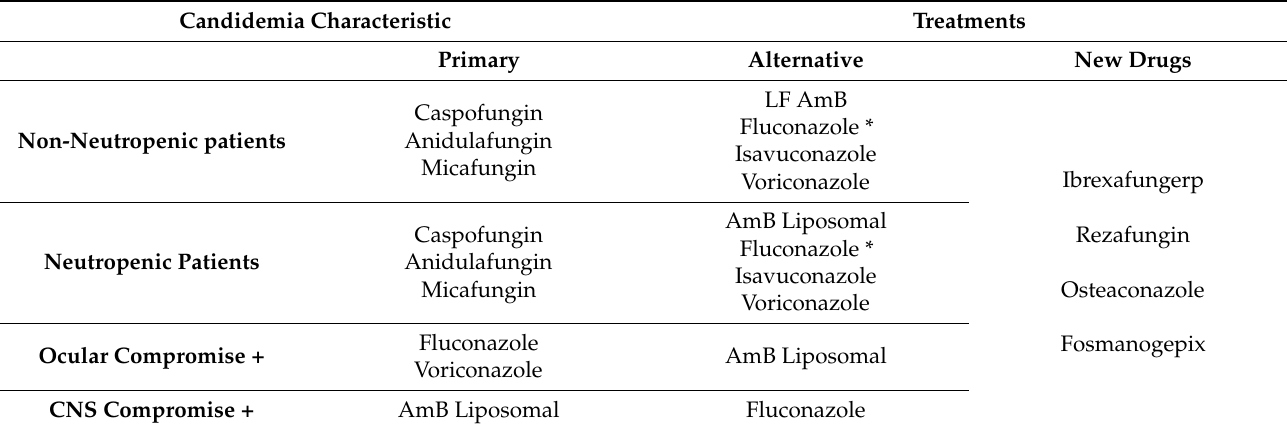
Table 1. Suggested Drugs for Treatment of Invasive Candidiasis